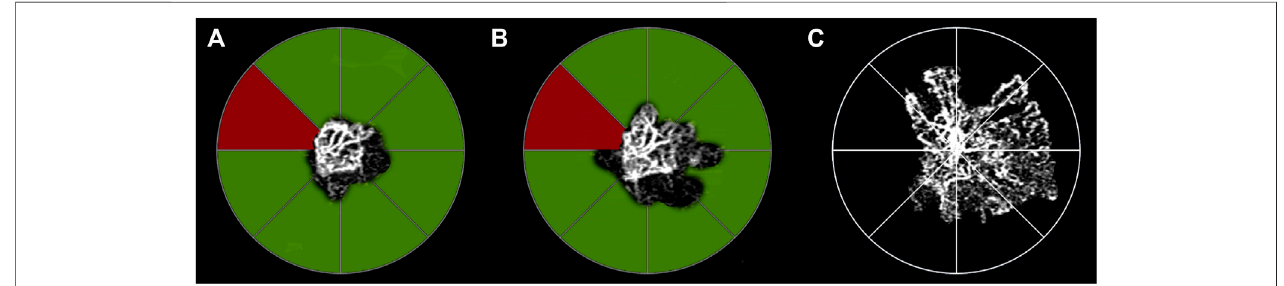
FIGURE2| Sector analysis oflowMNVre fl ectivity signal and changesin MNVsize.The segmentation oftheMNV isdivided intoeight sectors at baseline (A) (MNV size 0.56 mm 2 ). Green sectorscorrespondto MNV subregions characterized by lowMNV re fl ectivity signal at baseline, whereas red sectorsshow only ahigh re fl ectivity signal.In the sub-sequent follow-up examinations, green sectors correspond tochangesin MNV size ofat least 20%of the total MNV sizein the sector. The in fl uence of theincreaseinsizeontheneovascularnetworkisalreadydetectableaftertheloadingdoseofthree-monthlyinjections (B) (MNVsize0.78 mm 2 ).Thepersistenceof lowMNVre fl ectivitysignalsectorscanbeidenti fi edatthistime.ThesesectorsarecharacterizedbyfurtherincreasesinMNVsize,detectedattheendofthe1-yearfollow- up (C) MNV size 1.98 mm 2 ).